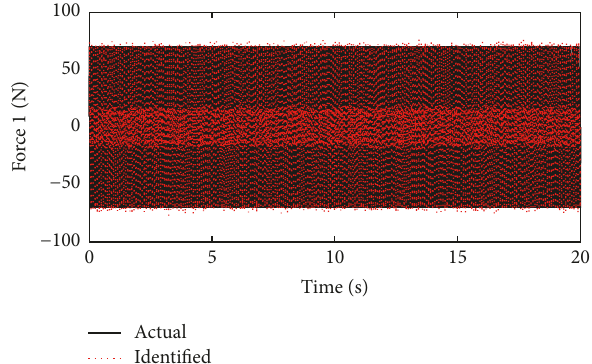
Figure 6: The actual and identified results of force 𝑢 1 by data fusion.